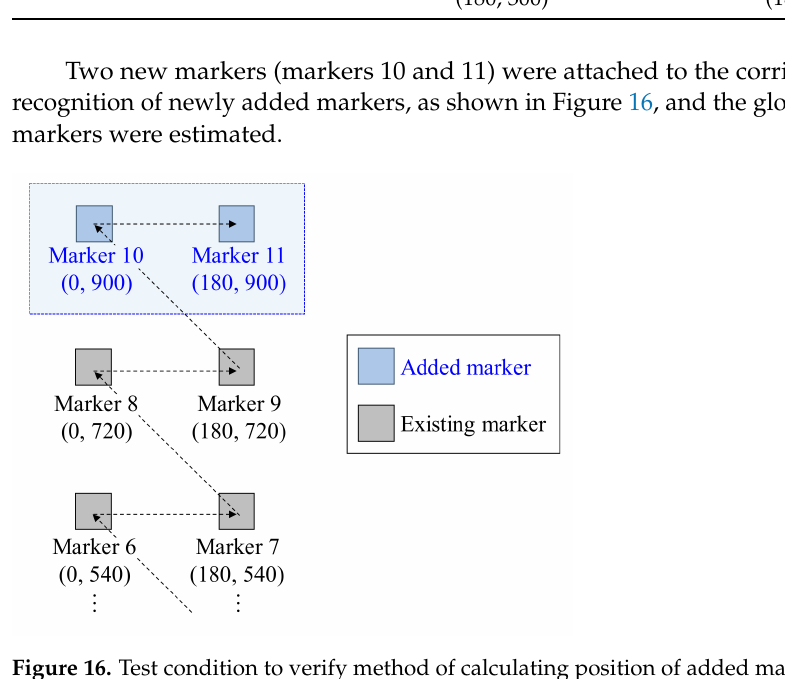
Figure 16. Test condition to verify method of calculating position of added marker.